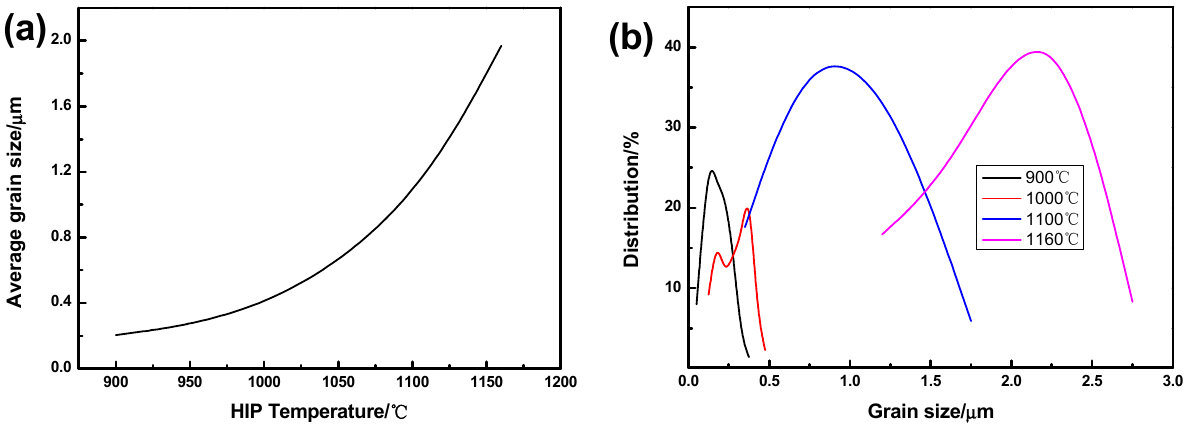
Figure 12. ( a ) Average grain size change at different HIP sintering temperature from 900 to 1160 ◦ C; ( b ) grain size distribution at 900, 1000, 1100, and 1160 ◦ C. Table 2 summarizes the different element contents of SEM-EDS and TEM-EDS point scan analysis in Figure 11. When the HIP sintering temperature was 700 ◦ C, the black area had a higher Cr of 21.5% and a slightly lower Ni of 13.1% (spectrum 1); the lighter area was the opposite, with a lower Cr of 16.9% and a slightly higher Ni of 15.1% (spectrum 2). The Cr content of austenite grains at 900 ◦ C was approximately 10%, slightly less than they were at 1000 ◦ C and 1100 ◦ C (between 11% and 12%), and the value for both temperatures was slightly less than they were at 1160 ◦ C (>12%). The contents of Fe, Mn and Ni in austenite remained essentially the same at different temperatures. The element Si at 900 ◦ C was significantly higher than it was at other temperatures. The boron content of the edge of the grain was greater than the interior (for example, spectrums 13, 14 of Figure 11e, spectrums 21, 22 of Figure 11f and spectrums 27, 28 of Figure 11g). The Cr, Ni and Fe contents in the boron-containing phase of large-sized grains were similar at different temperatures: Cr at approximately 57%, Fe at approximately 37%, and Ni at a lower content of approximately 1%. The elemental diffusion transition region appeared at 1100 ◦ C with 58.87% Fe, 27.34% Cr and 11.12% Ni (spectrum 24). The boron-rich zones occurred at 1160 ◦ C, with the